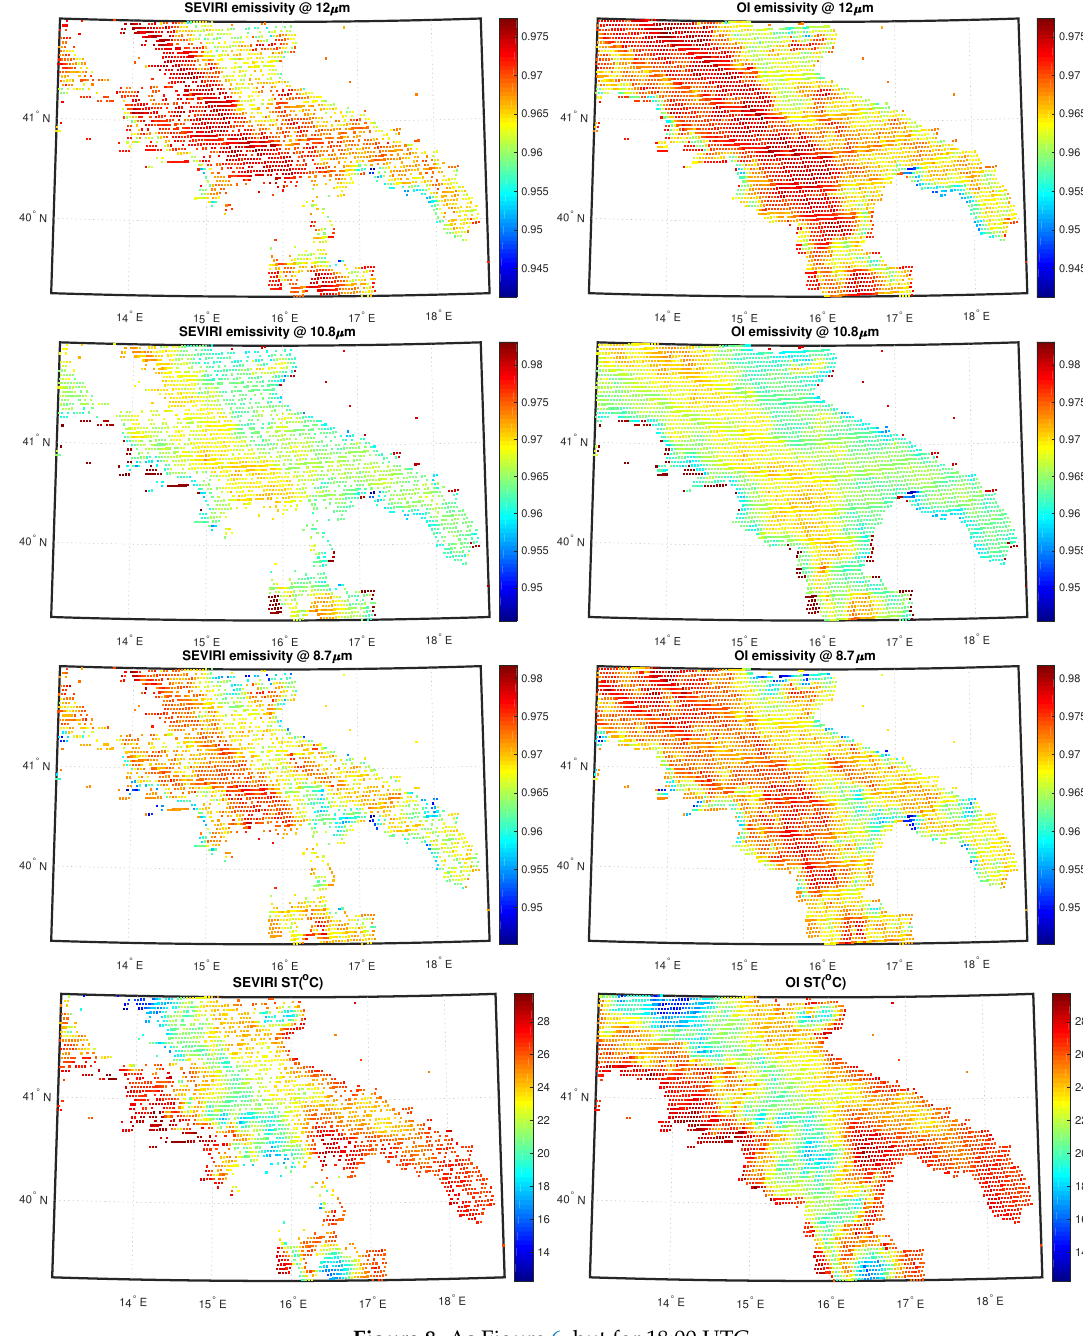
Figure 8. As Figure 6, but for 18:00